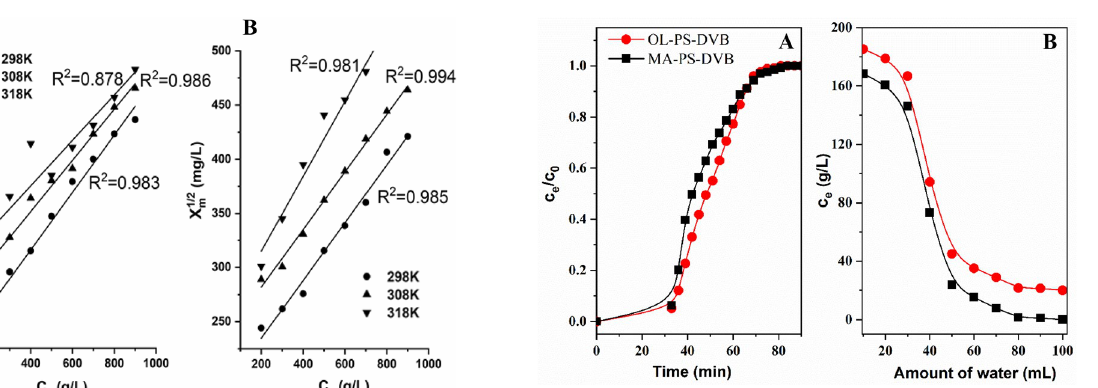
Fig. 5 The breakthrough curve of OL‑PS‑DVB and MA‑PS‑DVB ( A ); The elution curve for 1,3‑propanediol of OL‑PS‑DVB and MA‑PS‑DVB ( 20) ( B ) −